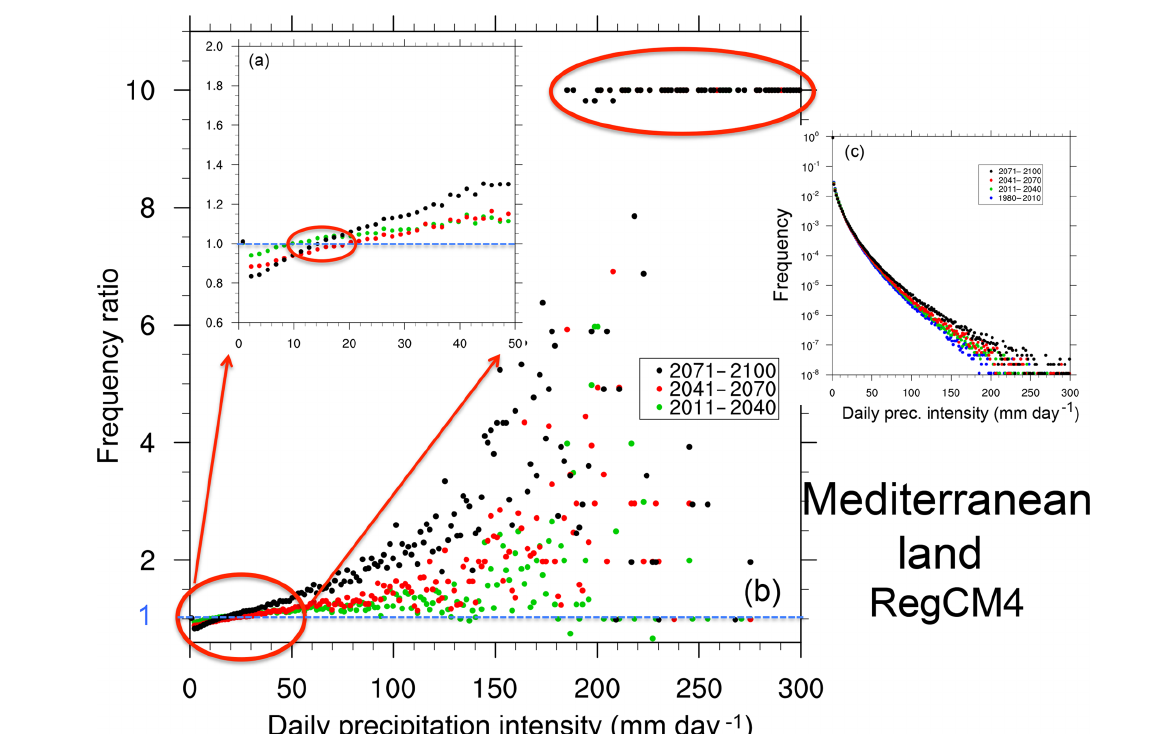
Figure 5. Same as Fig. 3 but for Mediterranean land areas in a MED-CORDEX experiment with the RegCM4 RCM driven by global fields from the HadGEM